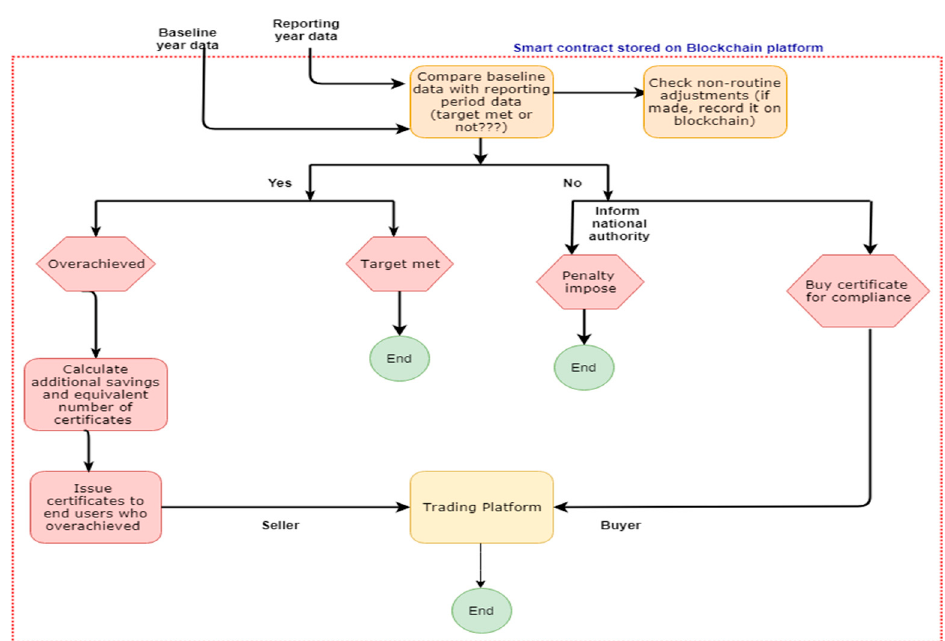
Figure 5. Process flow under smart contract on the blockchain platform.